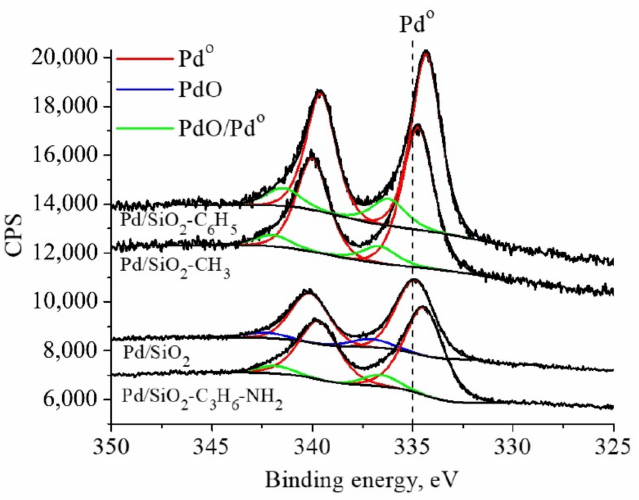
Figure 13. XPS of Pd 3d for Pd/SiO 2 , Pd/SiO 2 –NH 2 , Pd/SiO 2 –CH 3 , and Pd/SiO 2 –C 6 H 5